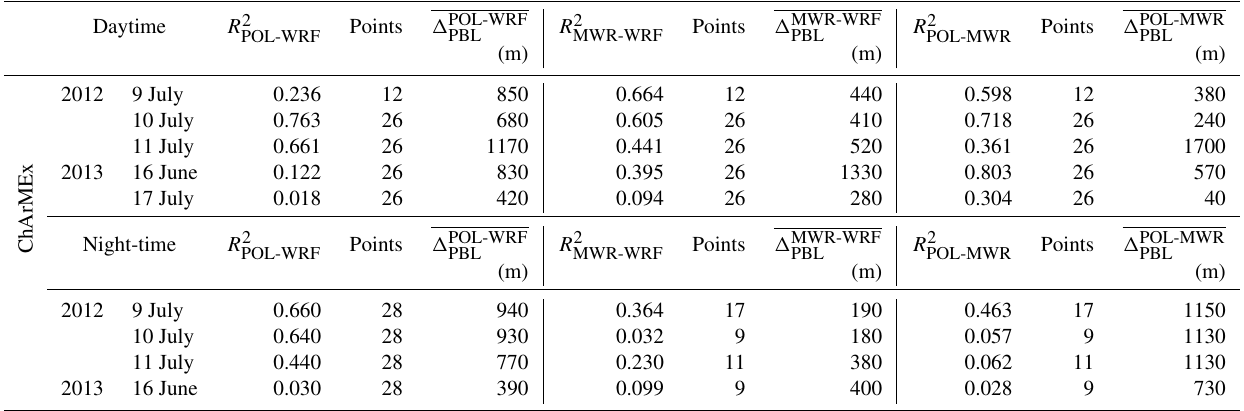
Table 1. R 2 among z POL , z MWR and z WRF during ChArMEx 2012 and 2013. Points are the number of values used to retrieve the correlation PBL PBL PBL factor. (cid:49) POL-WRF , (cid:49) MWR-WRF and (cid:49) POL-MWR are the mean differences between the z POL PBL PBL PBL between 06:00 and 19:00UTC (PBL means the ML) and night-time is the rest of the day (PBL means the RS).